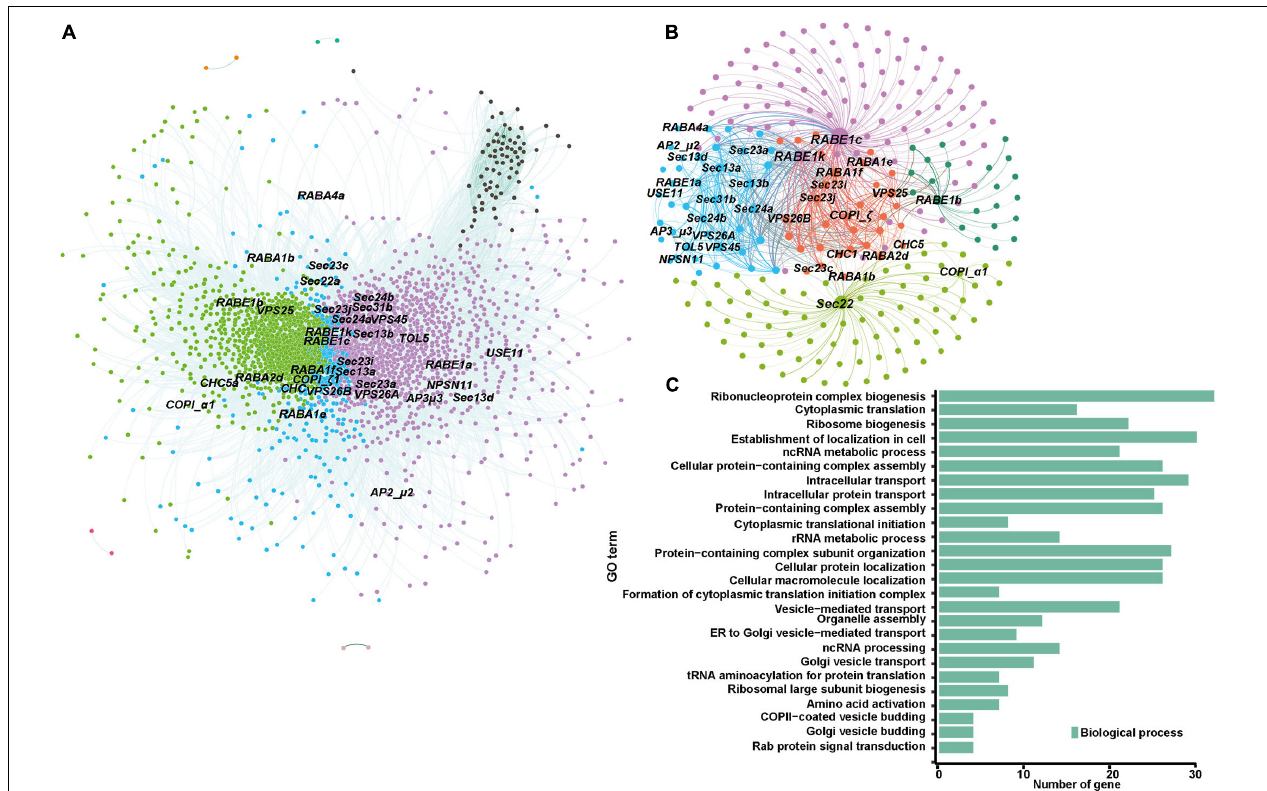
FIGURE 3 | Co-expression of membrane-trafficking genes during maize seed development. Nodes are color coded based on the consensus modules identified using the R language WGCNA package. Edges are constructed between genes with a correlation coefficient ( r ) > 0.2. (A) Co-expression network visualization for module turquoise identified in Supplementary Figure 17 . (B) The subnetwork with membrane-trafficking genes in module turquoise for visualization ( r > 0.2). (C) Gene ontology (GO) enrichment analysis of the subnetwork co-expressed genes.